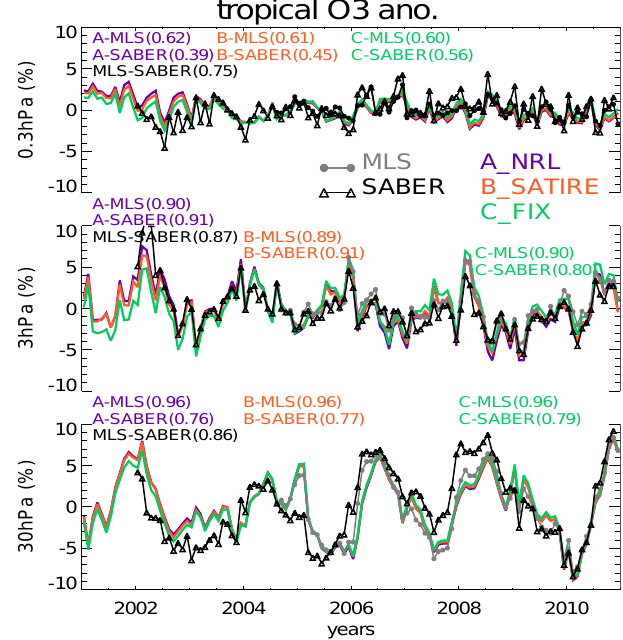
Fig. 3. Tropical (25 ◦ S–25 ◦ N) O 3 anomalies (%) from 3 model sim- ulations (run A_NRL – violet, run B_SATIRE – orange, run C_FIX – green) and satellite data (MLS (2004–2010) – filled circles, SABER (2002–2010) – triangles) at 30hPa (bottom), 3hPa (middle) and 0.3hPa (top). Monthly mean anomalies are calculated by subtract- ing climatological monthly mean values from each monthly mean. The climatological monthly means are over different time periods for individual satellite and model time series. The rank correlation between different O 3 anomalies is also